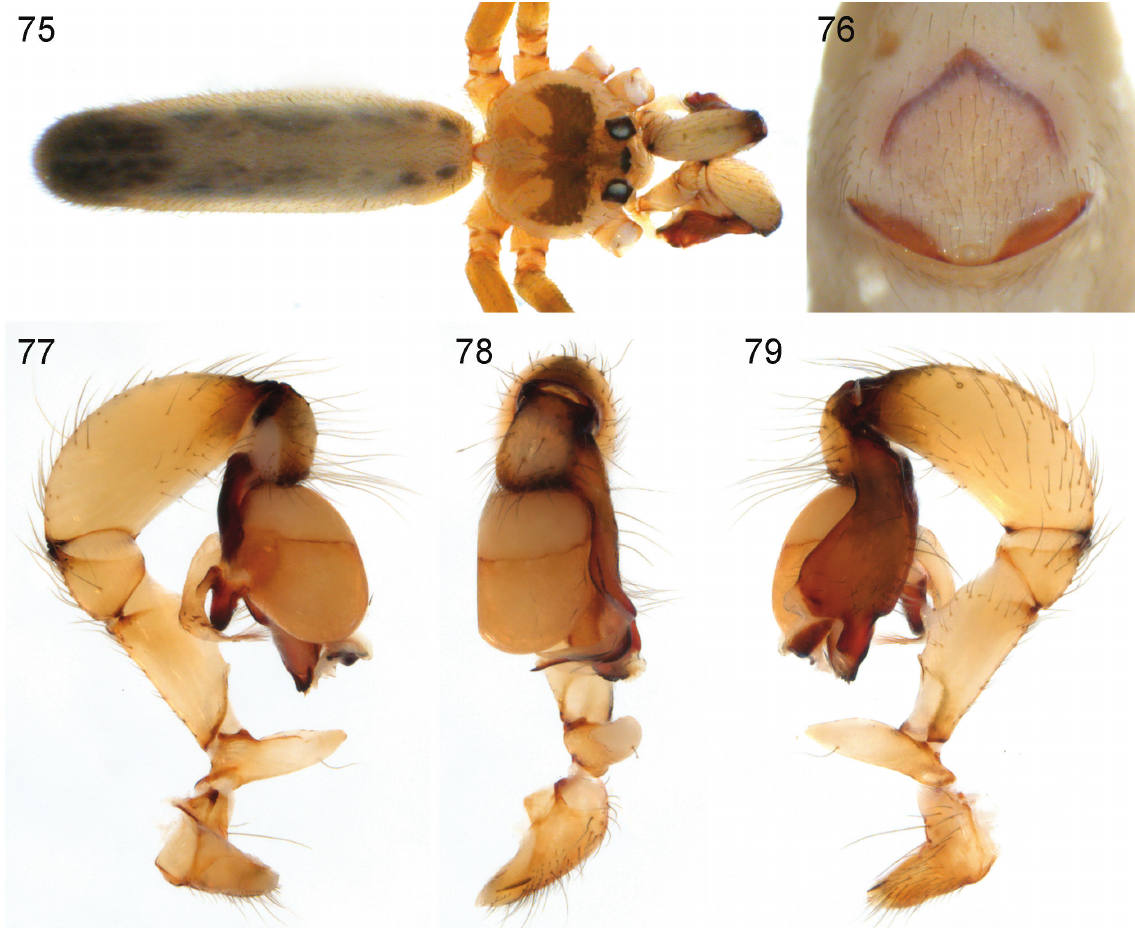
Figs 75-79. Pholcus rawiriae sp. nov. 75 . ♂, dorsal view. 76 . ♀ epigynum, ventral view. 77-79 . Left ♂ palp, prolateral, dorsal, and retrolateral